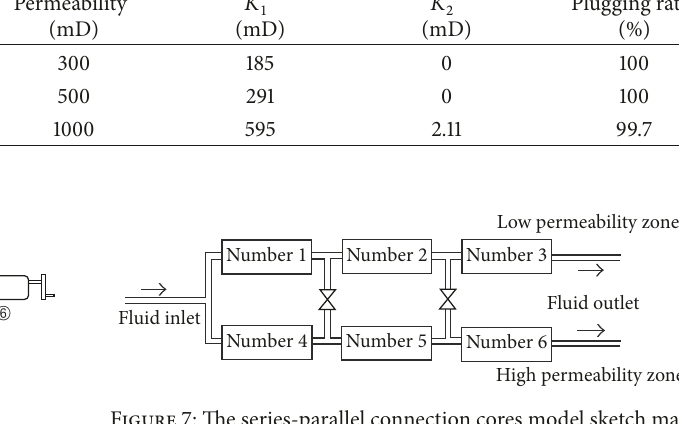
Figure 7: The series-parallel connection cores model sketch